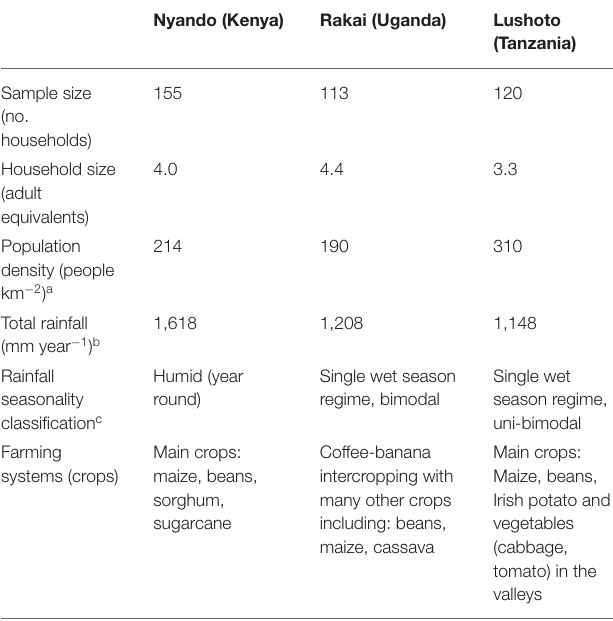
TABLE 1 | Characteristics of the three research sites in the East African highlands from the RHoMIS database (van Wijk et al., 2020). Nyando (Kenya) Rakai